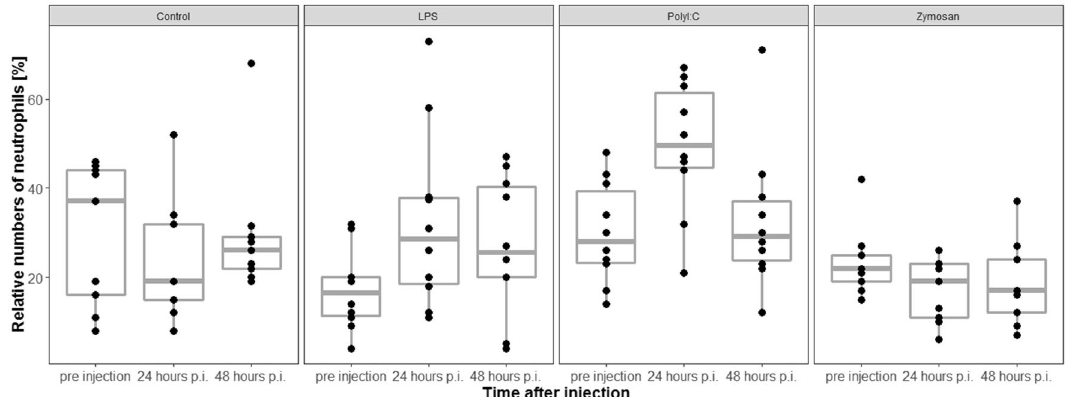
Figure 7. Relative numbers of neutrophils significantly increased in LPS- and PolyI:C injected individuals compared with control individuals. Relative numbers of neutrophils significantly increased in LPS- and PolyI:C injected individuals compared with zymosan injected individuals. p.i. = post injection. The figures show medians (bold line), 25–75% percentiles (box), maxima and minima (whiskers) and data points (dots).